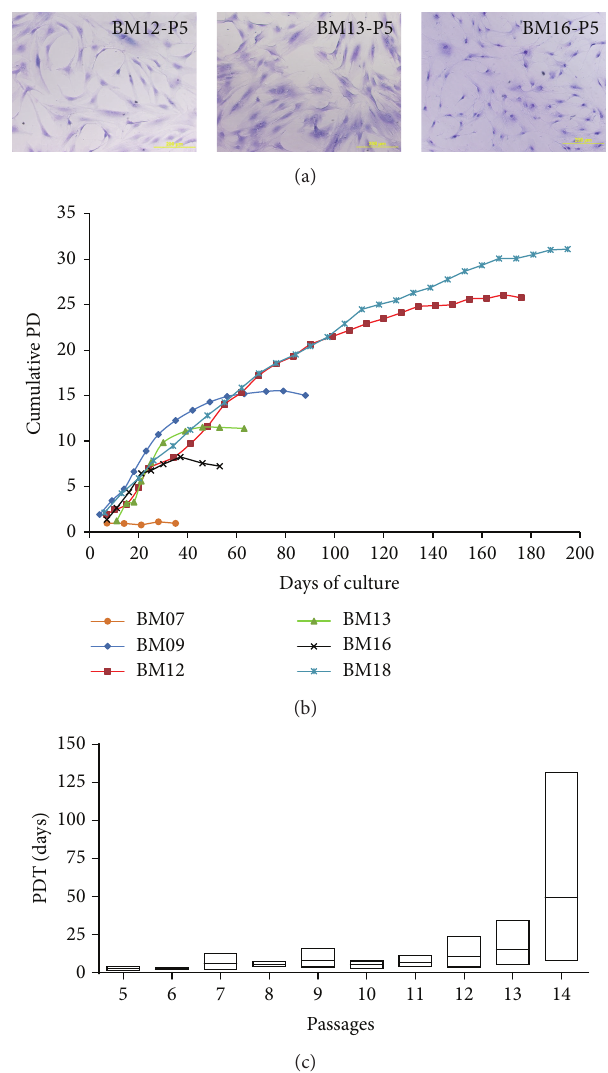
Figure 1: Morphological features and growth kinetics of BM-MSCs. (a) Representative images of BM-MSCs at an early passage (5th passage) showing that different morphology was observed in cells from different donors, ranging from a typical elongated and spindle- like shape (sample BM12) to an enlarged and irregular morphology (samples BM13 and BM16). Cells were stained with hematoxylin. Scale bar: 200 𝜇 m. (b) Cumulative population doublings (PD) of BM-MSCs from 6 young healthy donors until replicative senescence (growth arrest). Cell numbers were determined at every passage and cumulative PD was calculated. Each line represents BM-MSCs from onedonorandeachsymbolrepresentsonepassage.(c)ThemeanPD time (PDT) of multiple donors at each passage, showing increased interindividual growth variability and greater PDT over